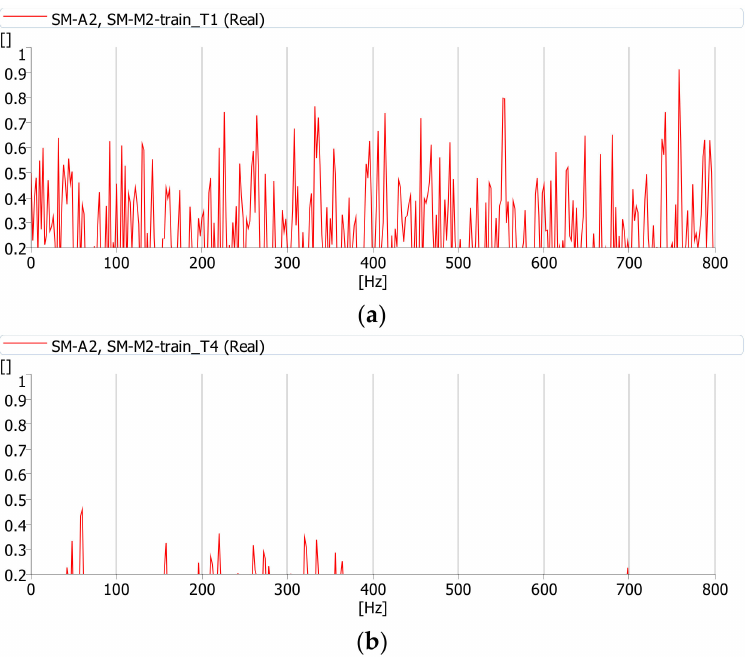
Figure 14. Coherence function between acoustic pressure at point M2 and vibrations at point A2 during the passage of a: ( a ) cargo train (T1), ( b ) passenger train